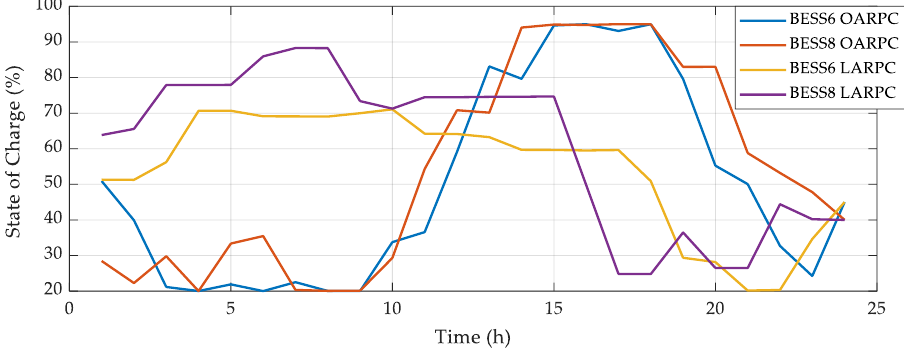
Figure 10. BESS scheduling under the LARPC and OARPC strategies for the selected